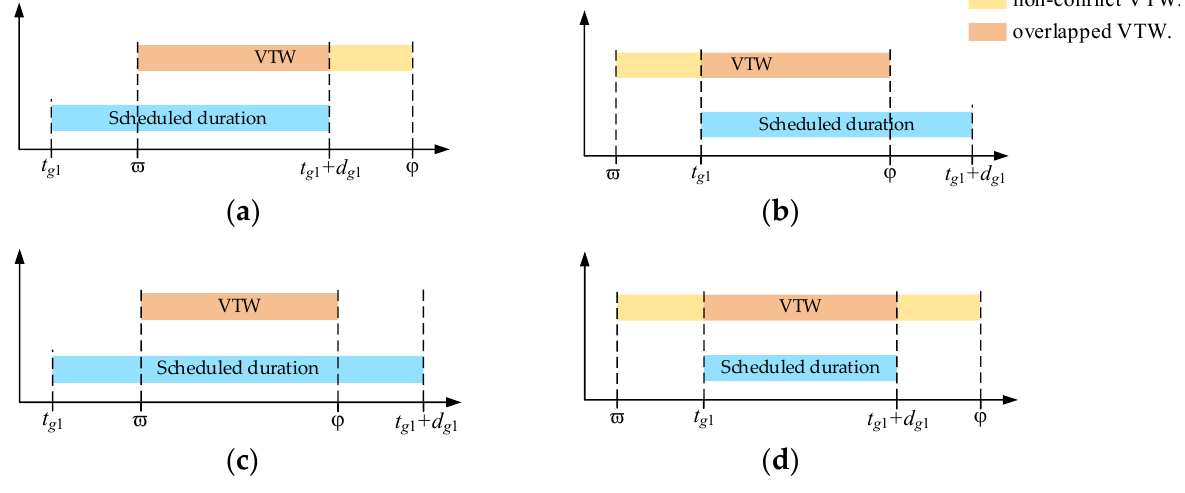
Figure 3. The analysis on the non-conflict VTWs where ( a ) the non-conflict VTW is located after the scheduled duration; ( b ) the non-conflict VTW is located before the scheduled duration; ( c ) there is no non-conflict VTW; and ( d ) the non-conflict VTW is split by scheduled duration into two parts.